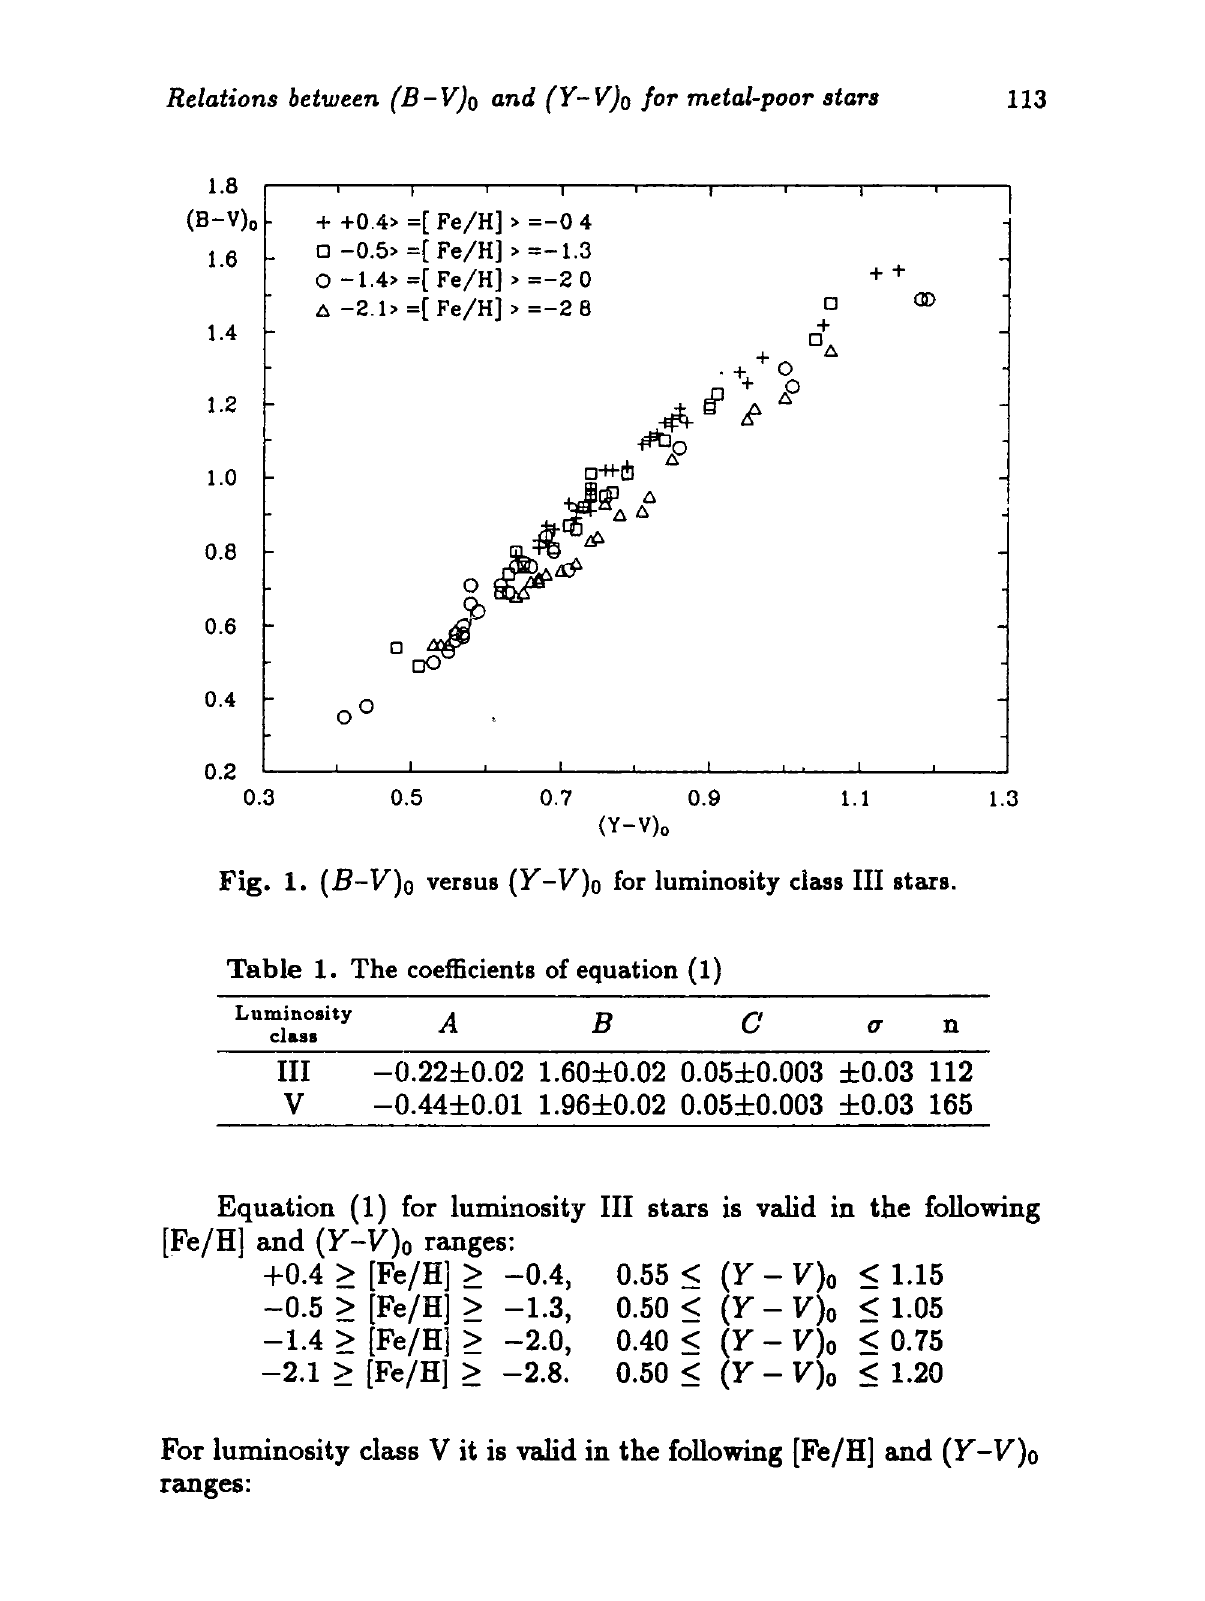
Fig. 1. (B-V) o versus (Y-V)o for luminosity class III stars. Table 1. The coefficients of equation (1) Luminosity